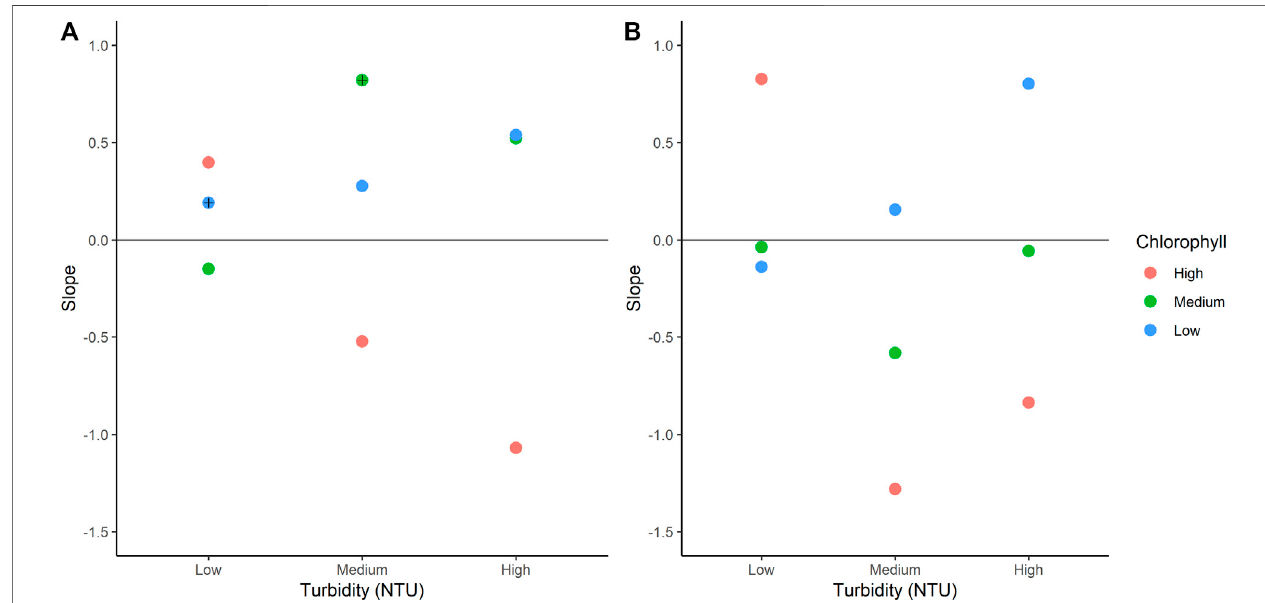
FIGURE 3 | Treatment slopes by sediment concentration. (A) , NB results; (B) , IB results. Each dot shows the calculated slope of chlorophyll values over time. Turbidity levels are indicated on the x -axis and chlorophyll-a levels are separated by color. Treatments with signi fi cant changes in slope are highlighted (+). NB means Natural Batata and IB means Impacted